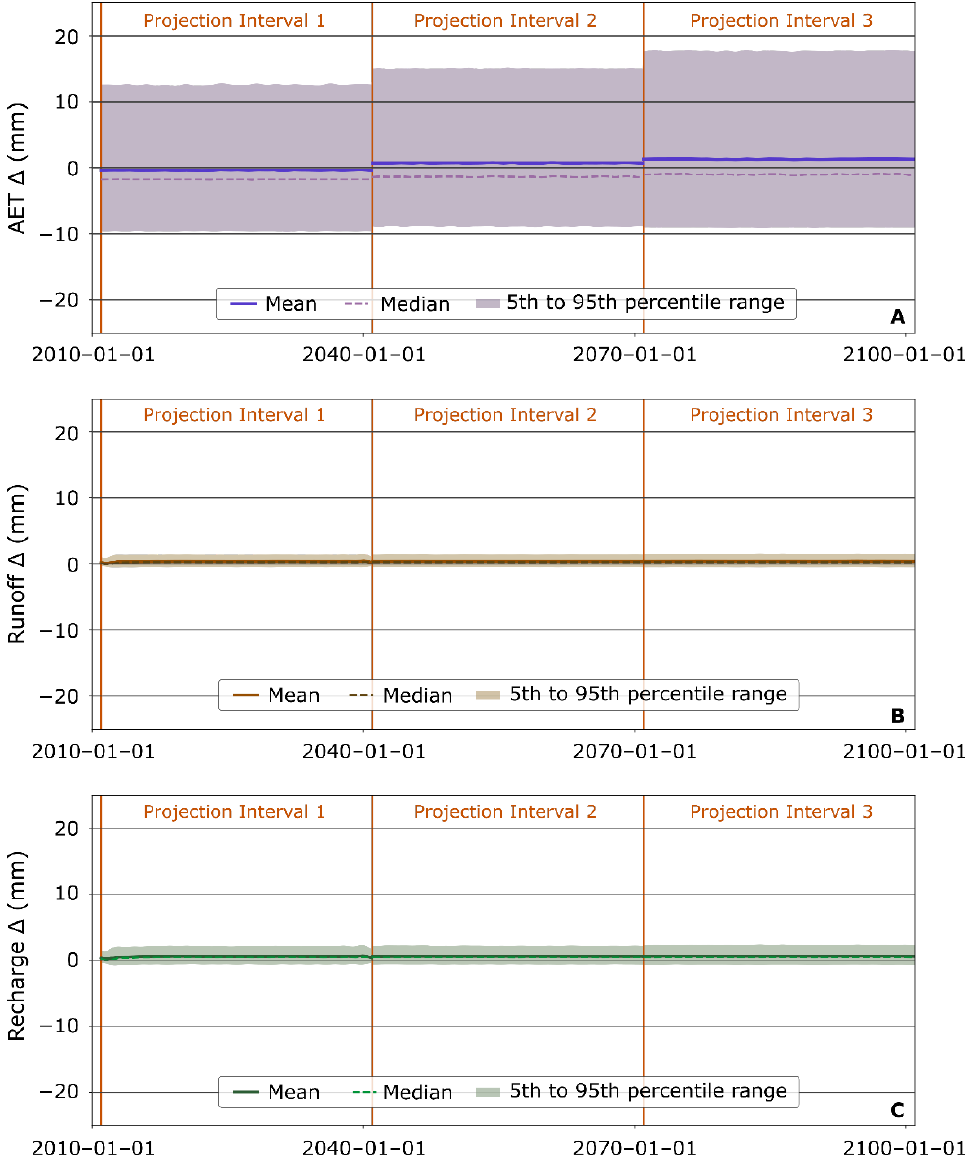
Figure 9. Monthly water balance modeling framework analysis— ∆ time histories. ( A ) AET is rela- tively unchanged for average conditions but maximum values increase due to increase in maximum precipitation values and water availability. ( B ) Runoff displays essentially no change on average but shows a slight positive bias for the 95th percentile. ( C ) Recharge also shows minimal increase on average and slight positive bias for the 5th to 95th percentile range due to simulation of larger magnitude extreme events in future